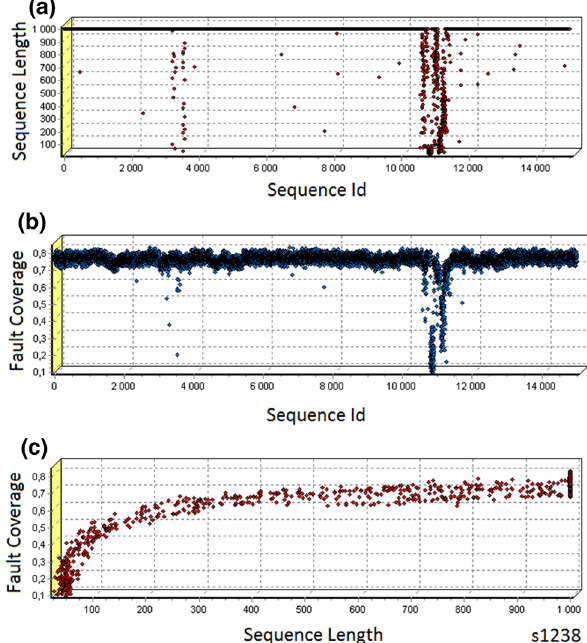
Fig. 17 Simulation graph for s1238 a sequence length vs. sequence id, b FC vs. sequence id and c FC vs. sequence length. STP (Id